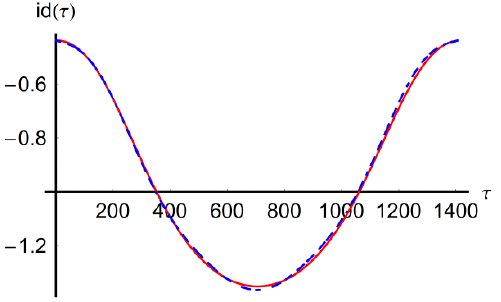
Figure 1. Comparison between the approximate solution and numerical integration results for i d : numerical, analytical solution (33) _______ numerical; _ _ _ _ _ analytical.